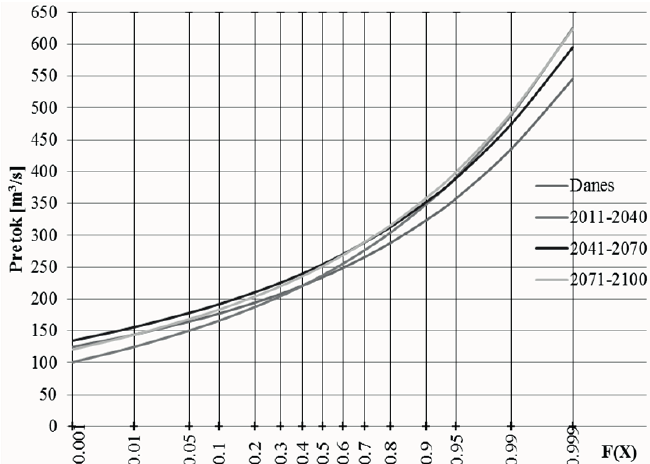
Fig. 3 Gumbel flood discharge probability functions for WS Miren including climate